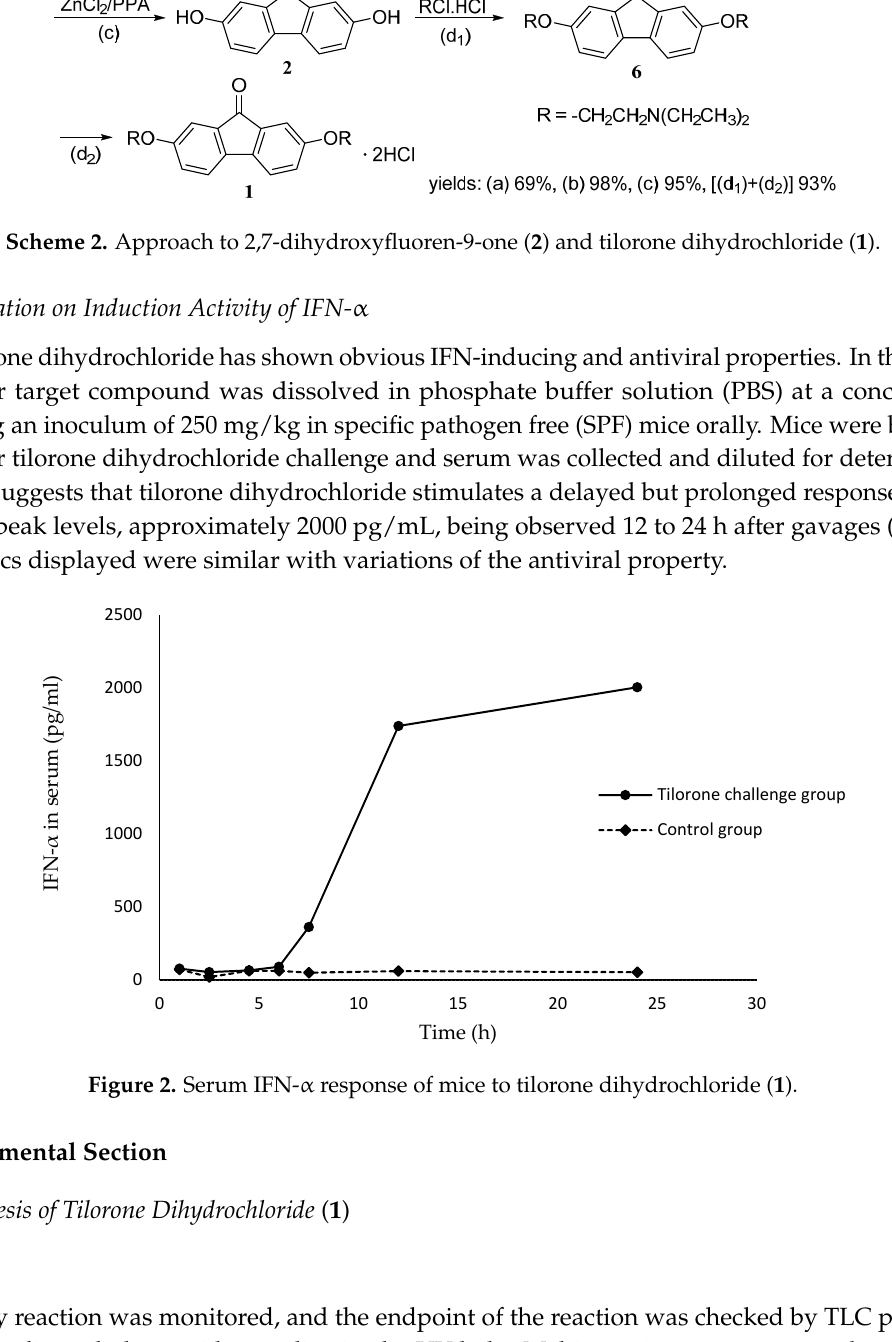
Figure 2. Serum IFN- α response of mice to tilorone dihydrochloride ( 1 ).